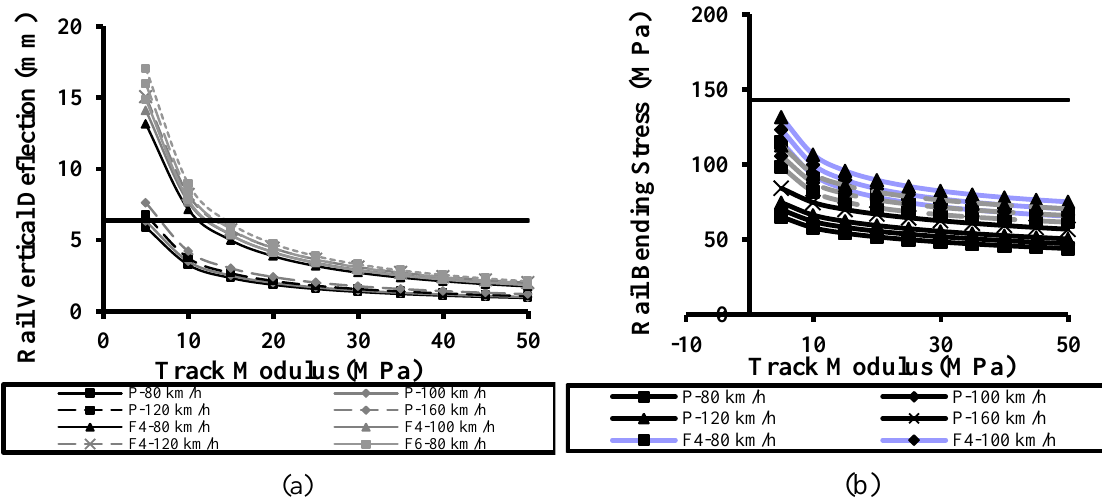
Fig. 2. Variations of a) rail deflection and b) bending stress as a function of track modulus and wagon